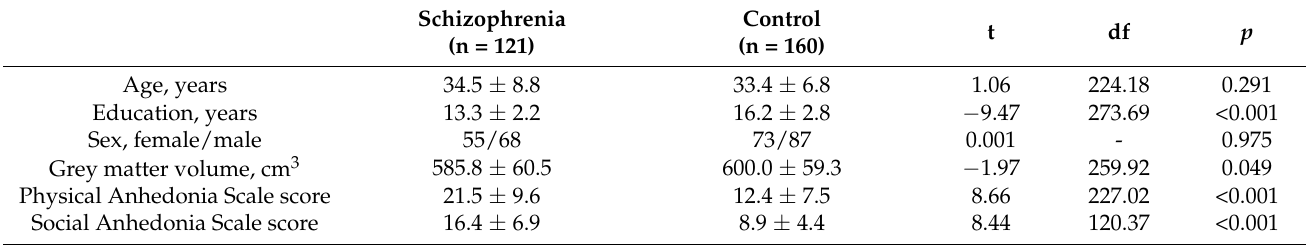
Table 1. Group comparison of the subject demographics and scale